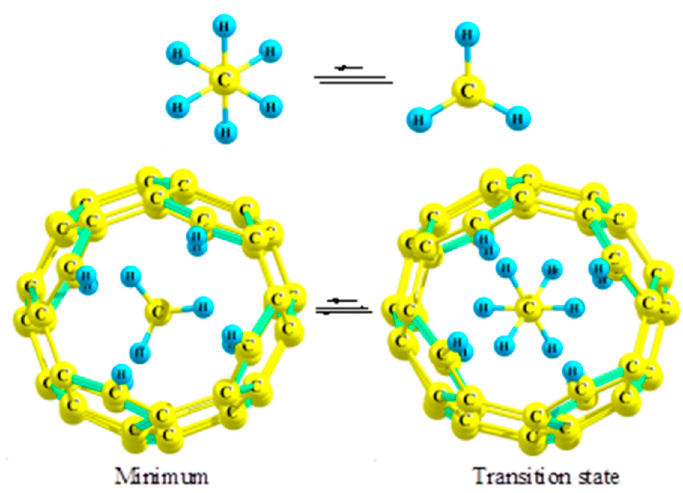
Figure 1. Conformational equilibrium of ethane: free and inside SWCNT (4,4). Adapted with modification [125]. Table 1. Energetical and structural parameters of C 2 H 6 @nanotubes (PBE / 3 ζ )